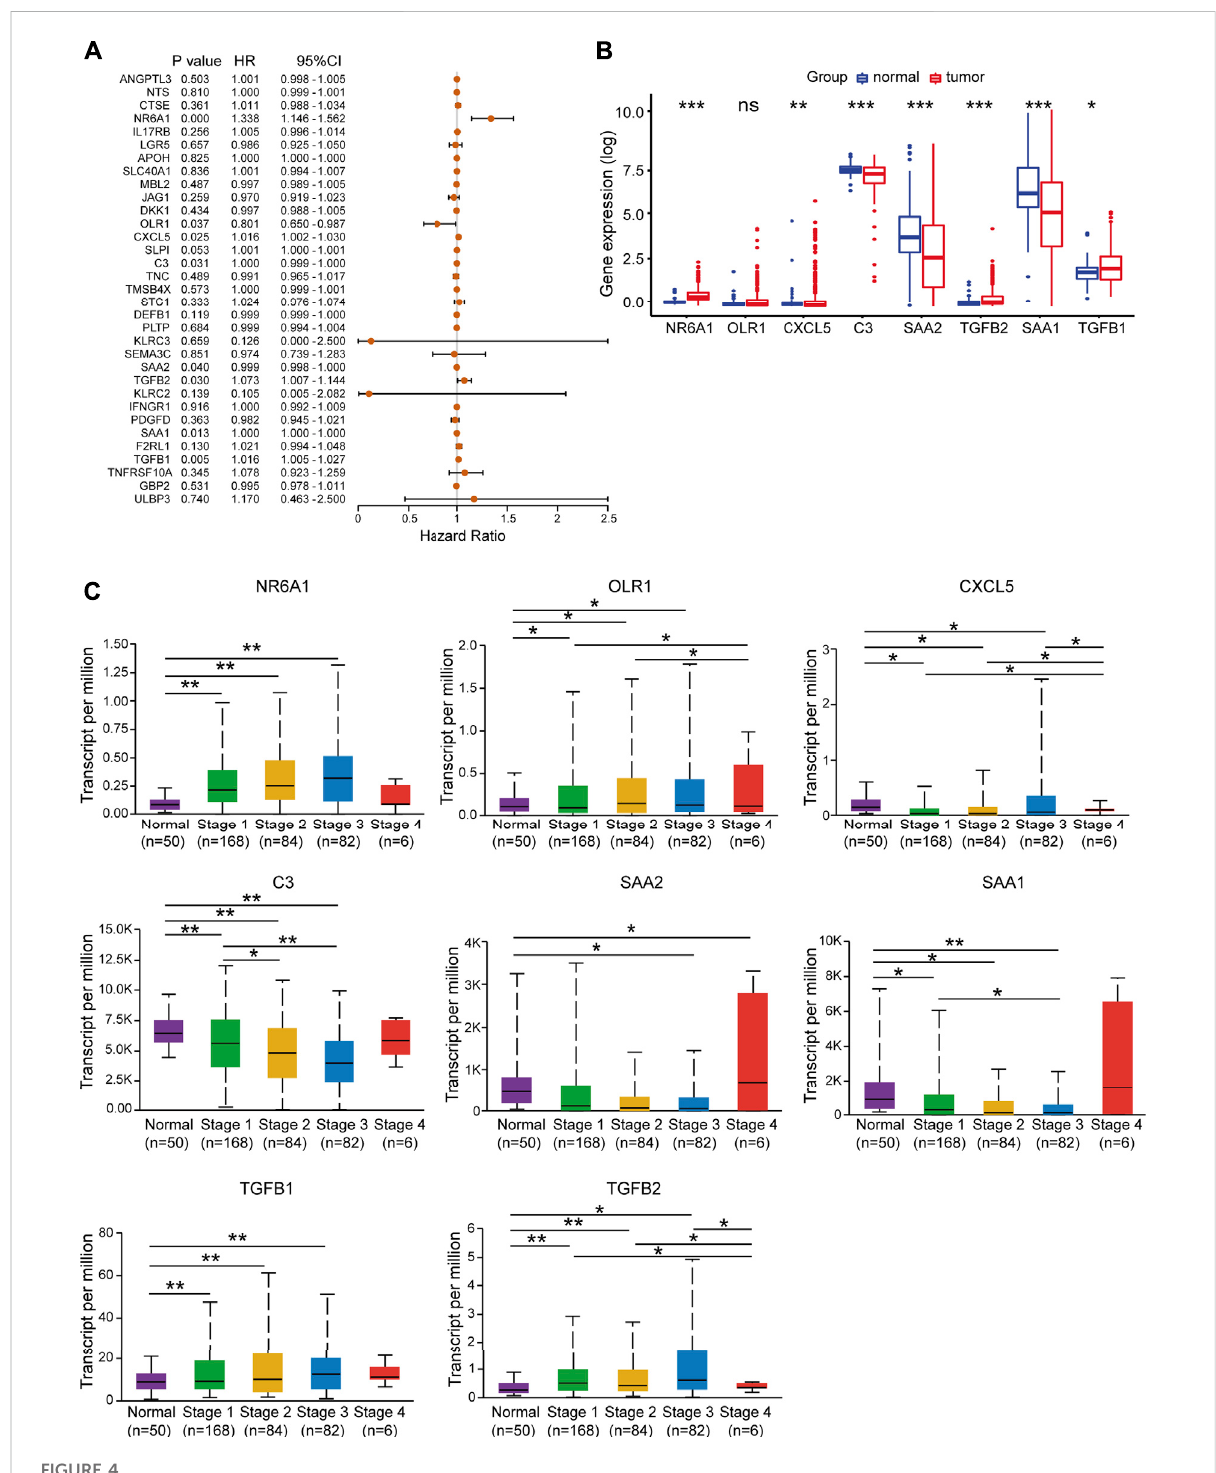
FIGURE 4 Identi fi cation of prognosis risk factors of sorafenib resistance. (A) Forest plot showing the prognostic values of DEIRGs in univariate Cox proportional hazards regression analysis. (B) Expression levels of eight prognosis risk factors between normal and LIHC patients in TCGA. (C) Expression levels of eight prognosis risk factors in LIHC patients in different